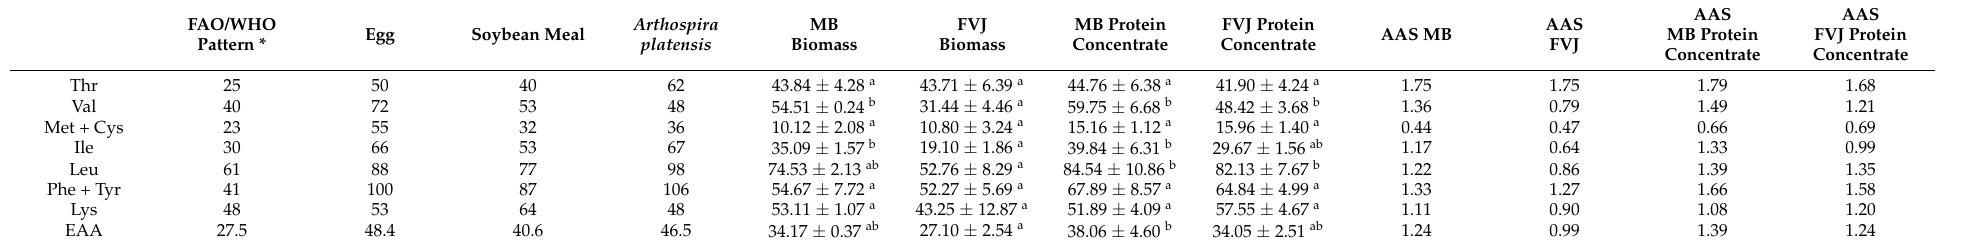
Table 9. EAA composition (mg/g protein and % respect protein) of FAO/WHO patterns, egg, soybean, Arthospira platensis , Chlorella protothecoides biomass grown in MB and FVJ media and protein concentrate of biomass grown in MB and FVJ media. AAS referred to FAO/WHO